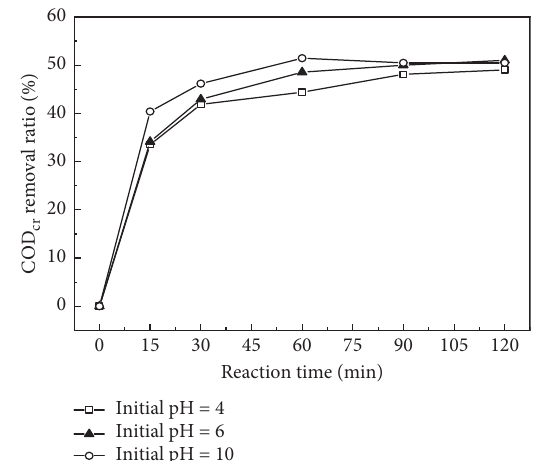
Figure 3: The infrared spectrum of simulated wastewater before and after natural sunlight irradiation for 48 hours.